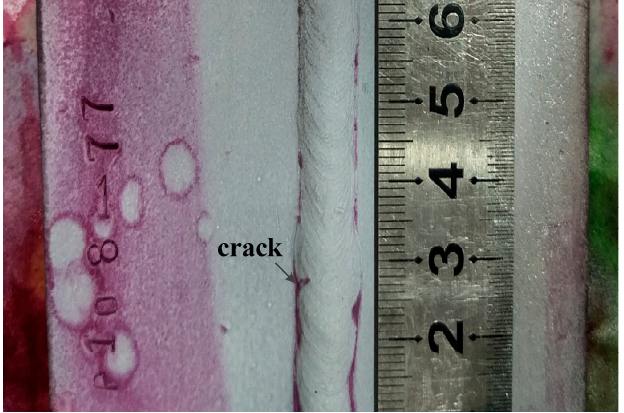
Figure 6. Penetration testing result on welding line sample (e).